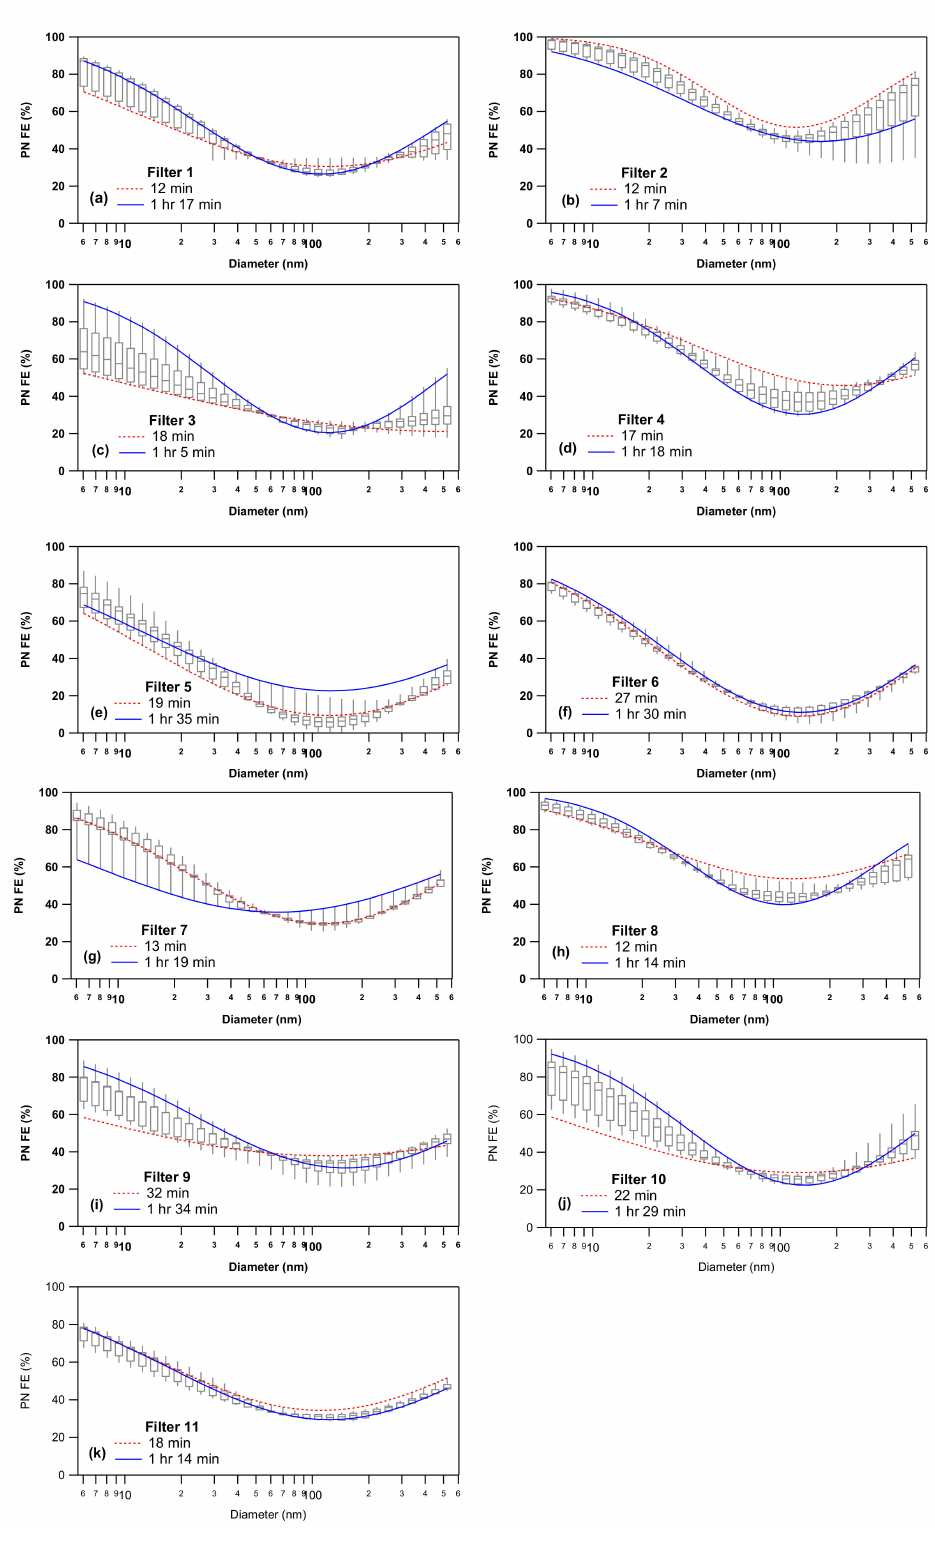
Figure 5. ( a – k ) Particle number filtration efficiency (PN FE) as a function of particle diameter for different cabin filters. Individual box represents the 30th, 50th, and 60th percentiles of the FE values over the course of the experiment, 20th and 80th percentiles are represented by the bottom and top whiskers, respectively. The dotted and solid curve represent the average PN FE at the beginning and the end of the